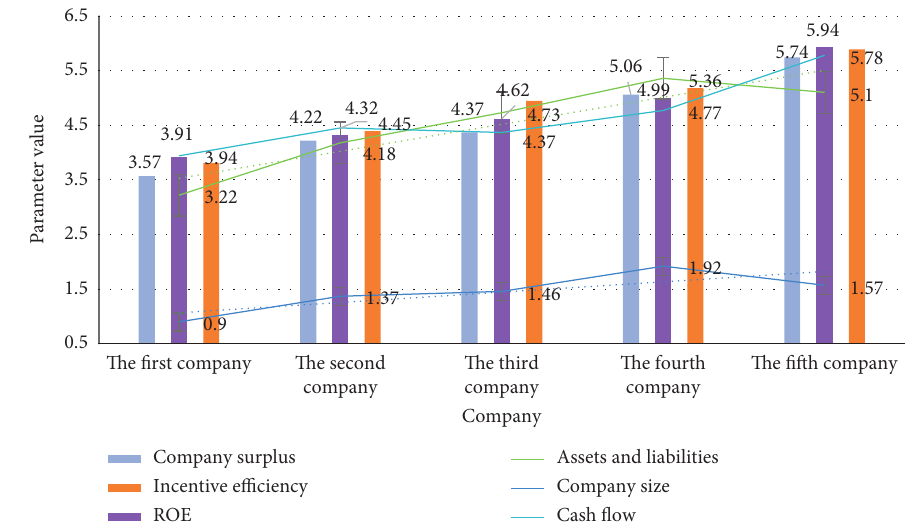
Figure 5: Improved employee